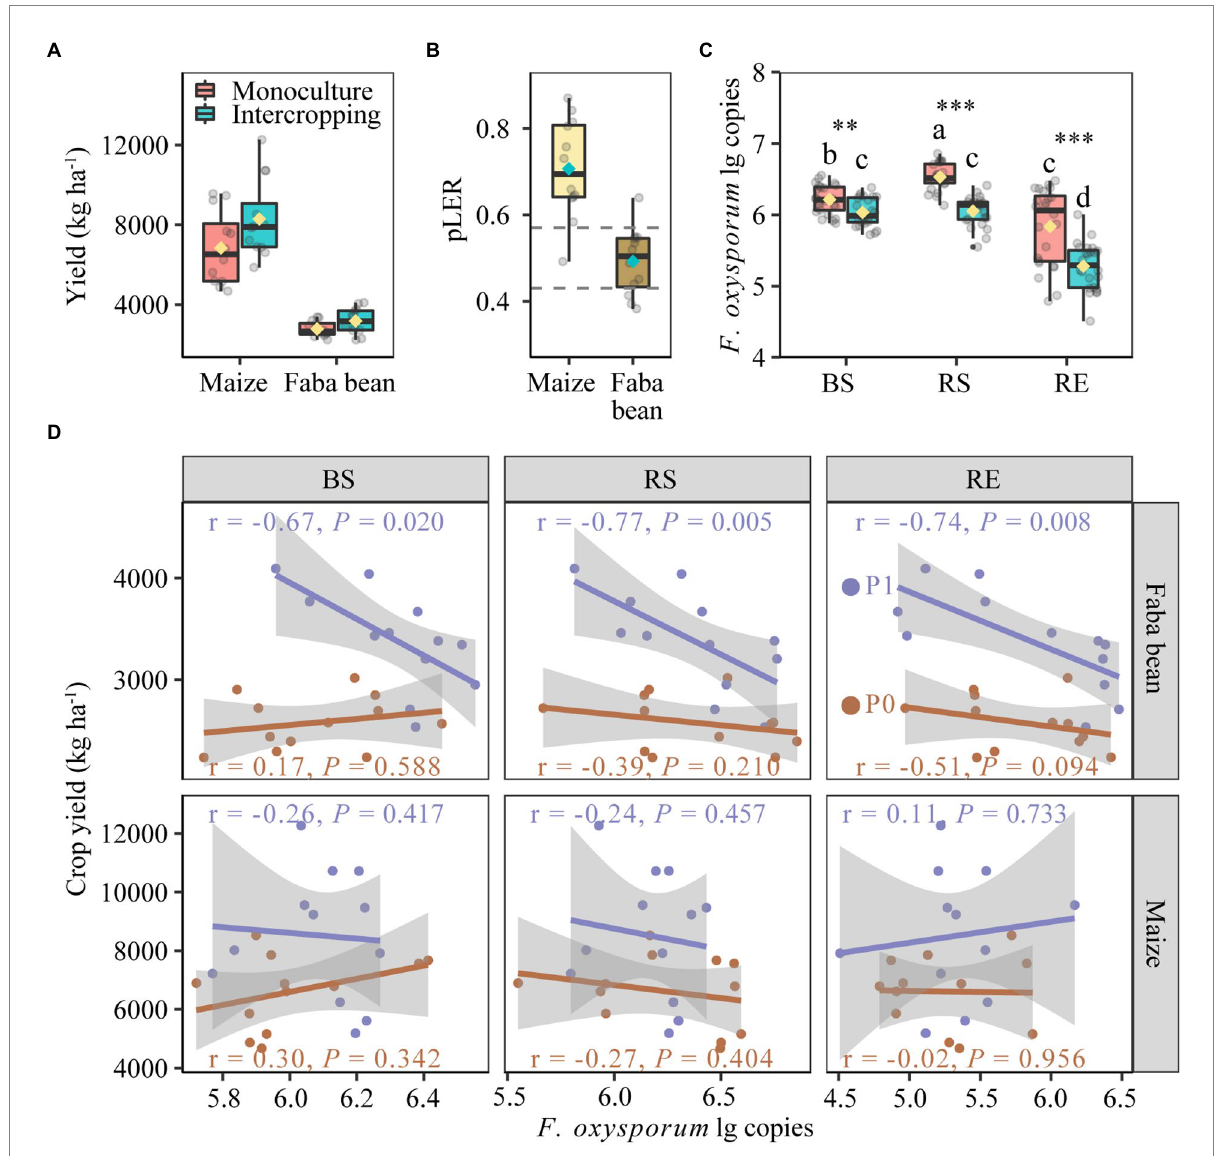
FIGURE 2 Yields of maize and faba in monoculture and intercropping (A) . Partial land equivalent ratio (pLER) of maize and faba bean in intercropping systems (B) . Fusarium oxysporum gene copies in bulk soil, rhizosphere and root endosphere of maize and faba bean (C) . Spearman correlations between yields of faba bean and maize with the abundance of Fusarium oxysporum in bulk soil, rhizosphere and root endosphere at zero P fertilization and 40 kg P ha − 1 yr. − 1 (D) . In each box plot the top and bottom of each box represent the 25th and 75th percentiles, the horizontal line inside each box represents the 50th percentile/median and the whiskers represent the range of the points excluding outliers. The diamonds of cyan and yellow are the average of the boxplot. In panel (B) . The values of dashed lines are the relative densities of intercropped maize (0.57) and intercropped faba bean (0.43) with respect to the respective monocultures. In panel (C) , bars with different letters indicate significant differences by Duncan’s multiple range test ( p < 0.05). Monoculture, n = 24; intercropping, n = 24. BS, bulk soil; RS, rhizosphere soil; RE, root endosphere; P0, no P fertilization; P1, 40 kg P ha − 1 yr. − 1